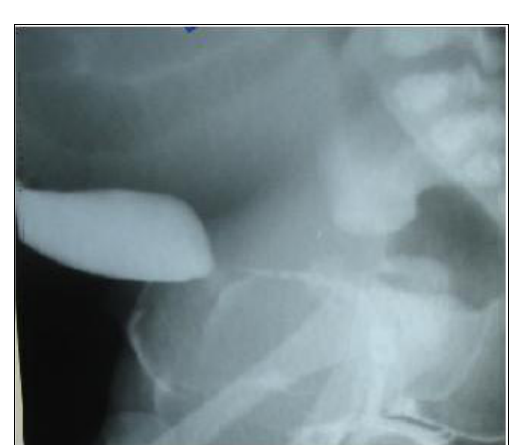
Figure 3: Genitogram shows no communication with vagina and urinary system.